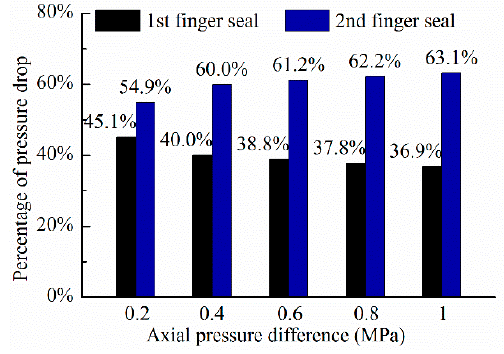
Figure 17. Effect of axial pressure difference on the inter ‐ stage pressure drop characteristics.